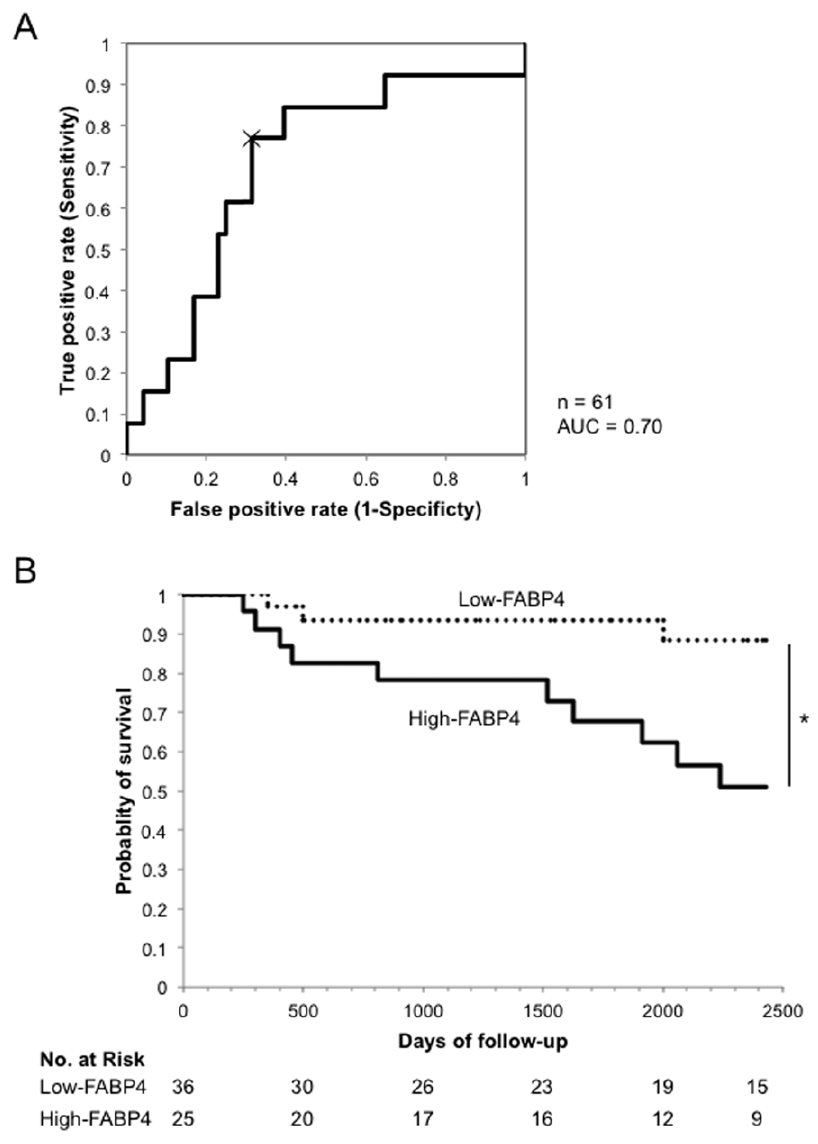
Figure 2. Receiver operating characteristic (ROC) analysis and Kaplan-Meier survival curve. (A) ROC analysis of the correlation between FABP4 levels in HD patients and the occurrence of cardiovascular death is shown. The ordinate values show the corresponding true-positive rate (fraction of patients with that FABP4 level who died) and the abscissa values show the corresponding false-positive rate (fraction of patients with that FABP4 level who did not die). The inflection point (indicated by X) was chosen as the optimal cutoff value, 364.1 ng/ml (sensitivity: 76.9%, specificity: 68.8%, area under the curve [AUC]: 0.70). (B) According to the cutoff point of FABP4 level, HD patients were divided into two groups: Low-FABP4 and High-FABP4 groups, and Kaplan-Meier curves for cardiovascular death are analyzed in the two groups. Broken lines (Low-FABP4 group), patients with FABP4 levels of , 364.1 ng/ml (n=36, 22 males and 14 females); Solid lines (High-FABP4 group), patients with FABP4 levels of $ 364.1 ng/ml (n=25, 9 males and 16 females). Survival rates were compared by log-rank test. *P , 0.05.